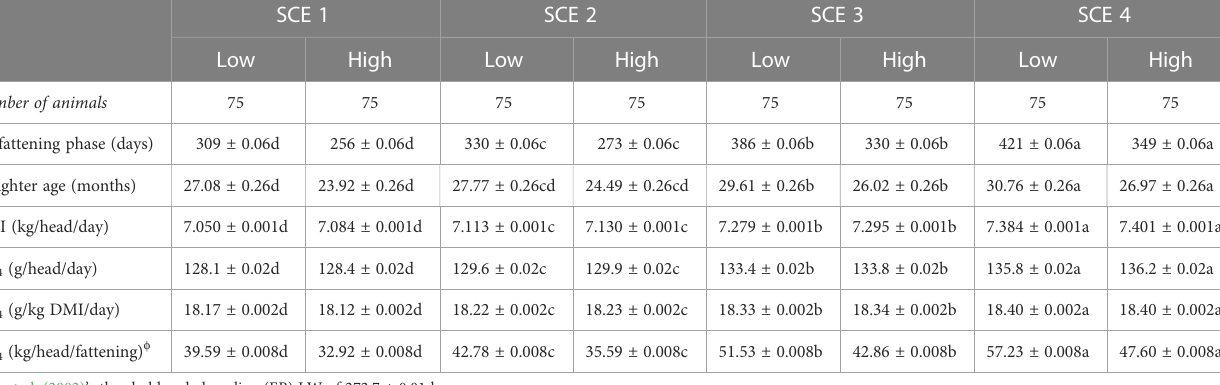
‡ in relation to slaughterhouse LW scenarios (SCEs) ϯ